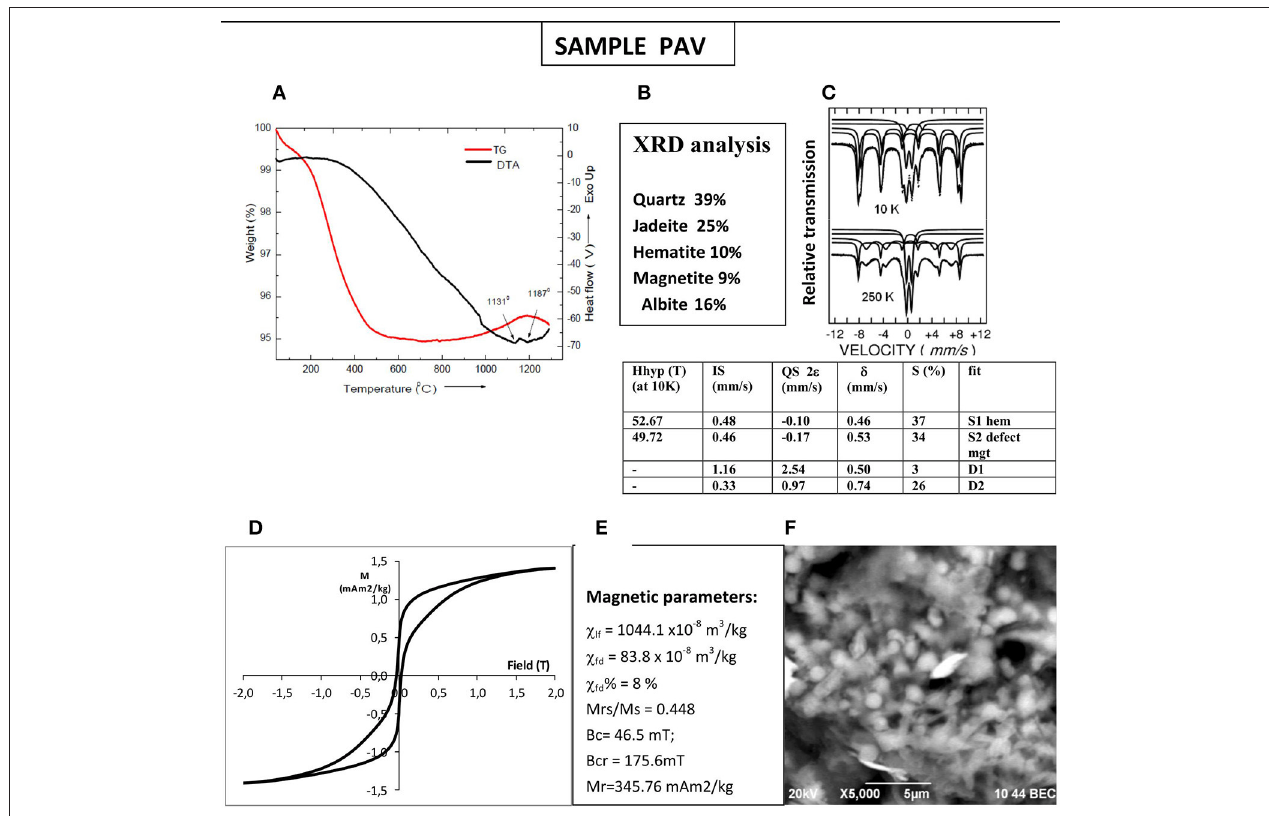
FIGURE 7 | Mineralogical and mineral magnetic characterization of sample PAV. (A) thermogravimetry and differential thermal analysis; (B) qualitative XRD analysis; (C) Moessbauer spectra at 10 and 250K and fitted parameters for 10K spectrum listed in the Table: Hhyp, hyperfine field; IS, isomer shift; QS, quadrupole splitting; δ , hyperfine splitting; S%, relative area; (D) hysteresis loop at room temperature; (E) magnetic parameters—bulk low-field susceptibility ( χ ), frequency dependent susceptibility ( χ fd ), and percent frequency dependent magnetic susceptibility χ fd%, hysteresis parameters and ratios; (F) SEM microphotograph of spherules, trapped within the glassy matrix, found in the black concretions in the brick